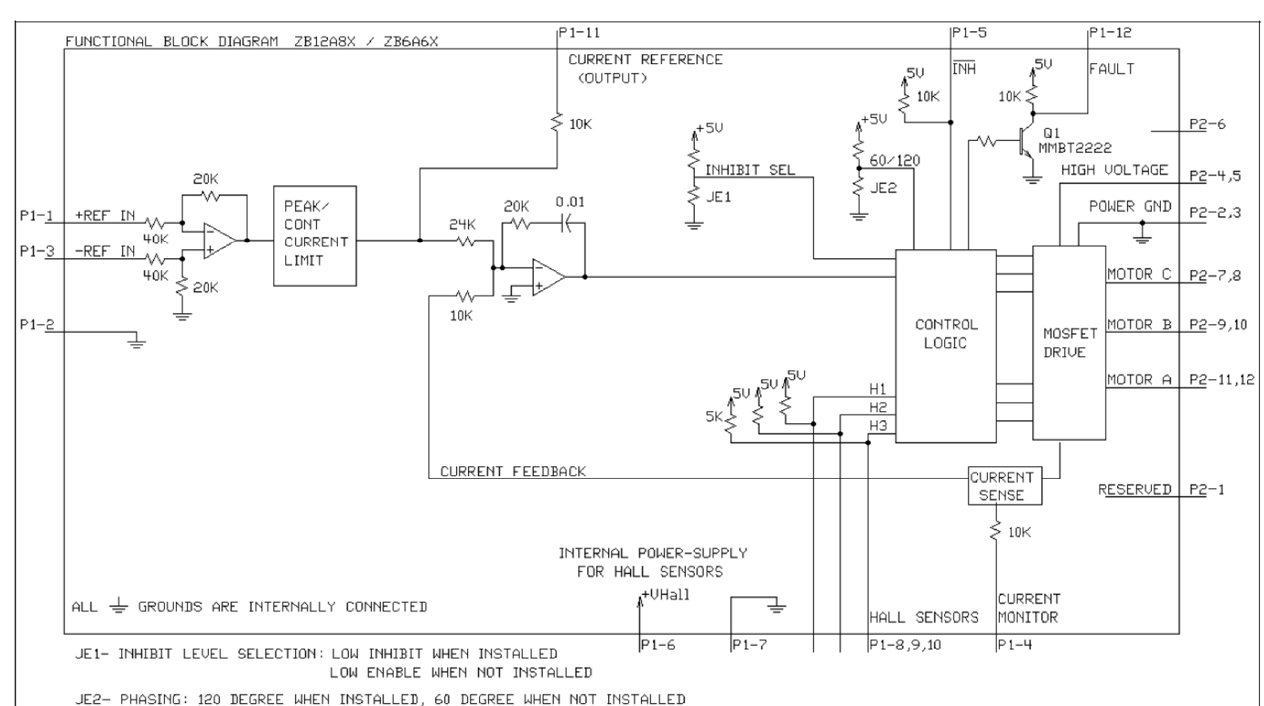
Figure A1. Block diagram of brushless PWM servo amplifier, model: ZB12A8, advanced motion controls (source: https://www.a-m-c.com/product/zb12a8/, accessed on 9 May 2022).